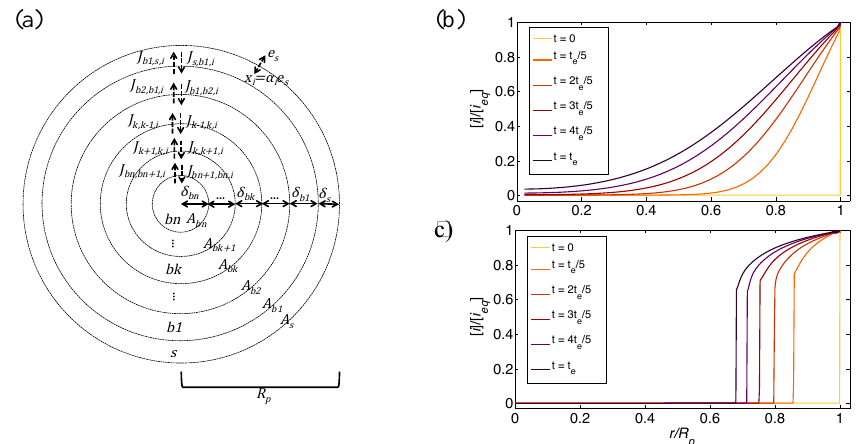
Figure 1. (a) A schematic of a particle split into shells, as used in the diffusion models, with shell boundaries represented by lines, and symbols relating to those used in the model equations ( α i , X i and e s are the accommodation coefficient, particle-phase mole fraction and vapour-phase saturation ratio of the semi-volatile, respectively). The relative width of the surface shell is shown larger than that used in models for clarity. (b, c) The concentration-radius profiles estimated using the ETH model at various times during diffusion for a semi- volatile component diffusing inwards with an initial mole fraction of 0.01 and equilibrium mole fraction of 0.90 (instantaneous change in saturation ratio of 1–90% assuming ideality), where t e is the e -folding time. Note that the axes are relative, and normalised by the total radius ( R p ) of the particle on the abscissa and by the equilibrium concentration ( [ i ] eq ) on the ordinate. (b) is for the diffusion coefficient independent of composition and (c) is for the diffusion coefficient with a logarithmic dependence on mole fraction ( D 0 nv = 1 × 10 − 25 , D 0 sv = 2 × 10 − 9 m 2 s − 1 )